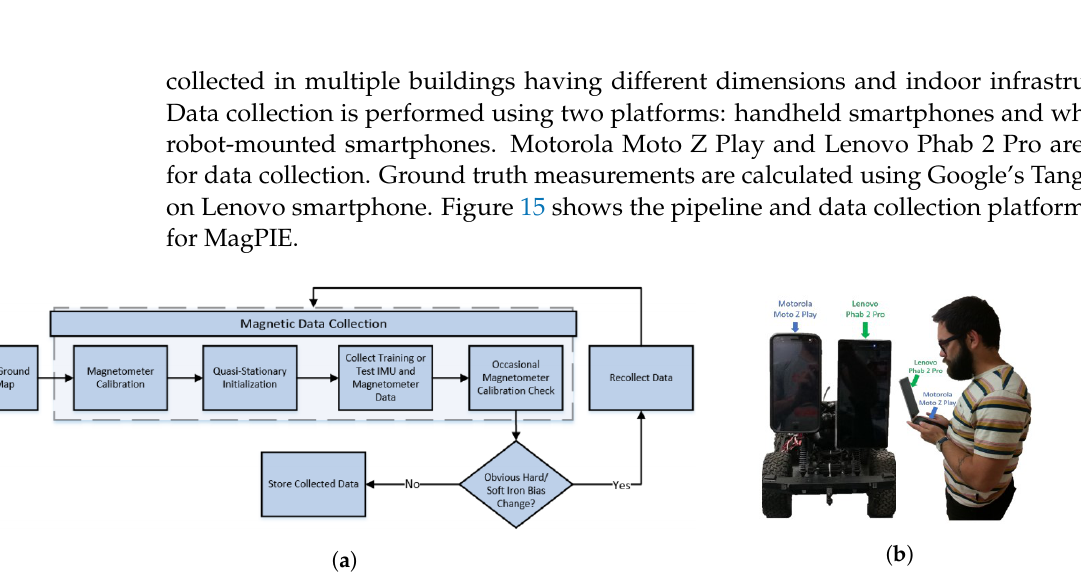
Figure 15. Data collection procedure for MagPIE, ( a ) The pipeline for the data collection, and ( b ) wheeled platform and handheld device for the data collection